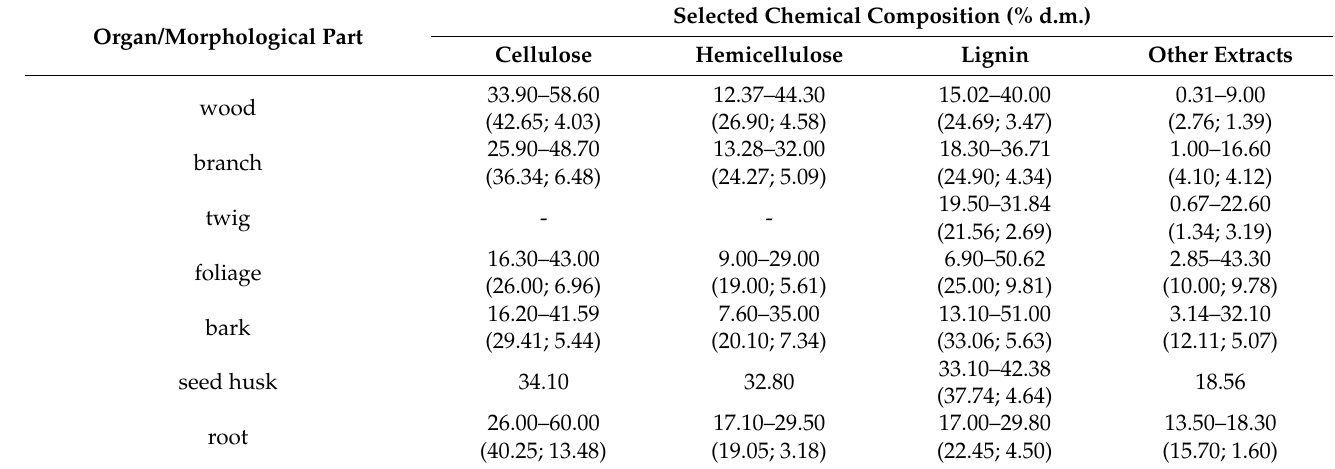
Table A9. Selected chemical composition of particular trees organs without differentiation by type according to the traditional division in forestry.